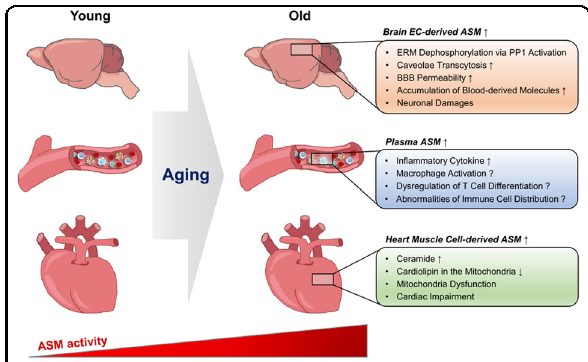
Fig. 1 ASM-mediated physiological dysfunction in aging. ASM activity increases with aging. In the aged brain, ASM levels increase in ECs of the BBB. EC-derived ASM induces BBB hyperpermeability by excessive caveolae transcytosis via PP1-mediated ERM dephosphorylation. This results in extravasation of blood-derived molecules into the brain parenchyma, leading to neuronal cell death and memory impairment. Plasma ASM levels also increase with aging, and ASM is likely to promote in fl ammation by causing immune cell dysfunction, such as macrophage activation and dysregulation of T cell differentiation. In aged hearts, increased ASM in muscle cells induces ceramide production. Ceramide mediates a decrease in mitochondrial cardiolipin, and this reduction contributes to mitochondrial dysfunction and cardiac